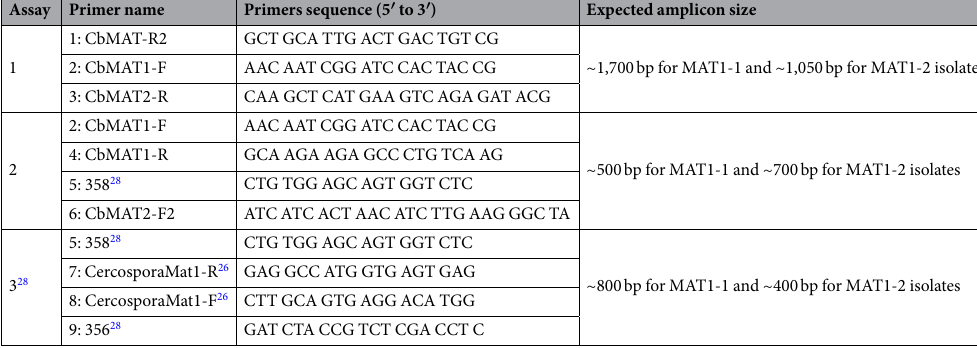
Table 5. Multiplex PCR assays and primers used for mating-type amplification and determination in Cercospora beticola populations. References are provided for the primers that were not designed in this